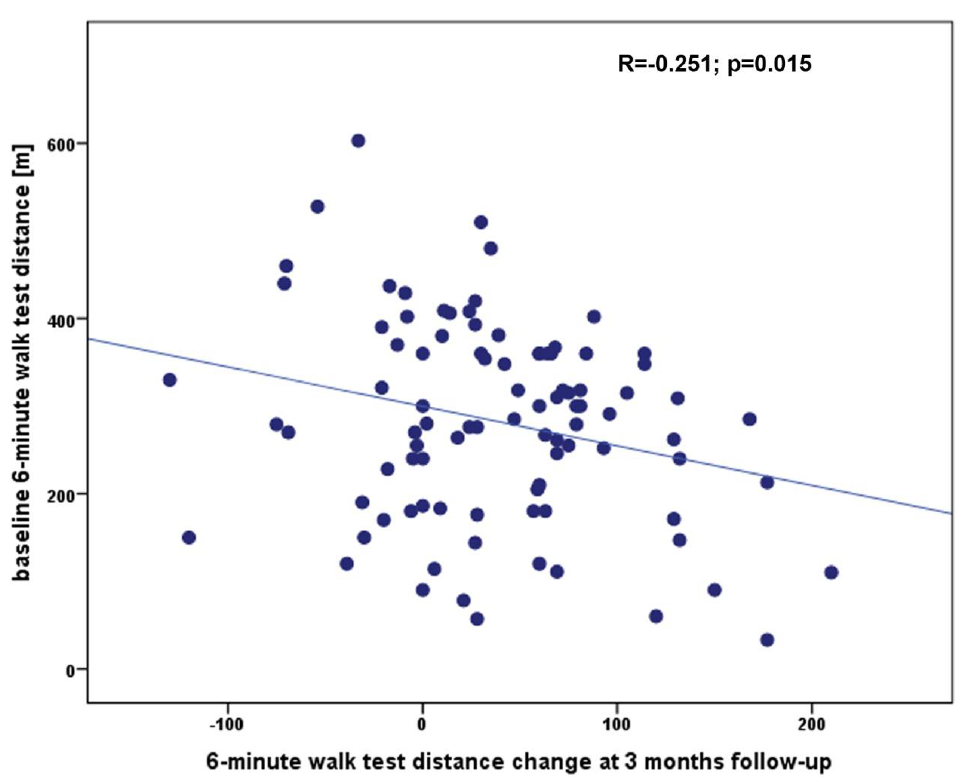
Figure 1. The correlation between the ∆ 6MWTD at the 3-month follow-up and 6 min walking test distance at baseline.